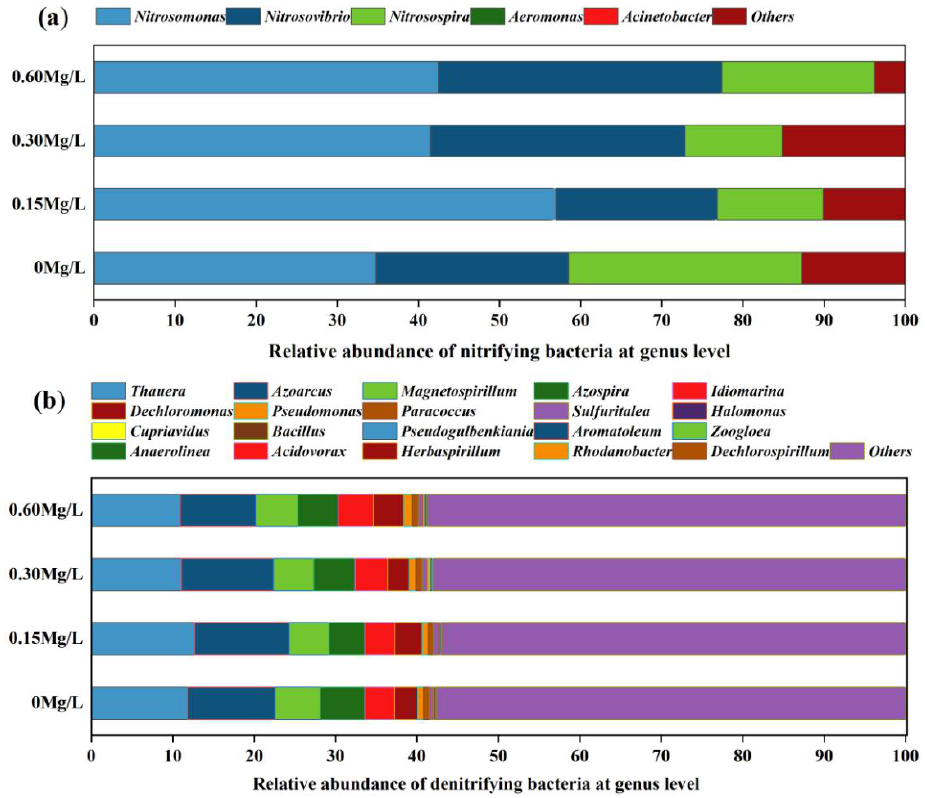
Figure 5. At genus level, species composition of nitrifying bacteria ( a ) (amoA gene) and denitrifying bacteria ( b ) (NirS gene) in different concentrations.